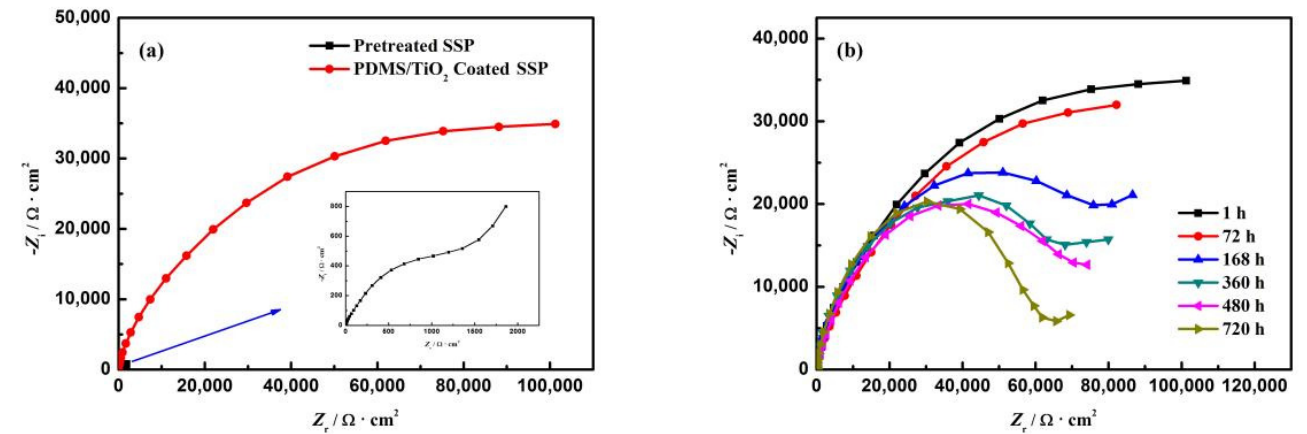
Figure 5. Nyquist plots of the coated mesh: after 1 h immersion ( a ) and a long-term test ( b ).